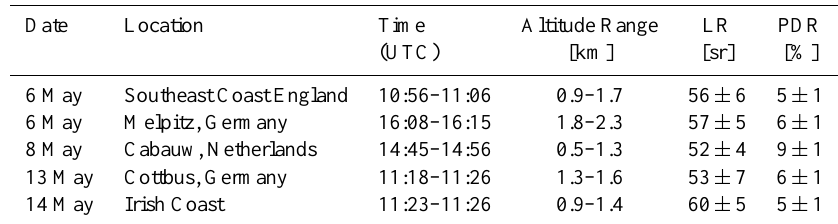
Table 1. Mean lidar ratio (LR) and particle linear depolarisation ratio (PDR) at 532nm for the analysed pollution layers shown in Figs. 6 and 7. ± -values indicate the mean systematic uncertainties.